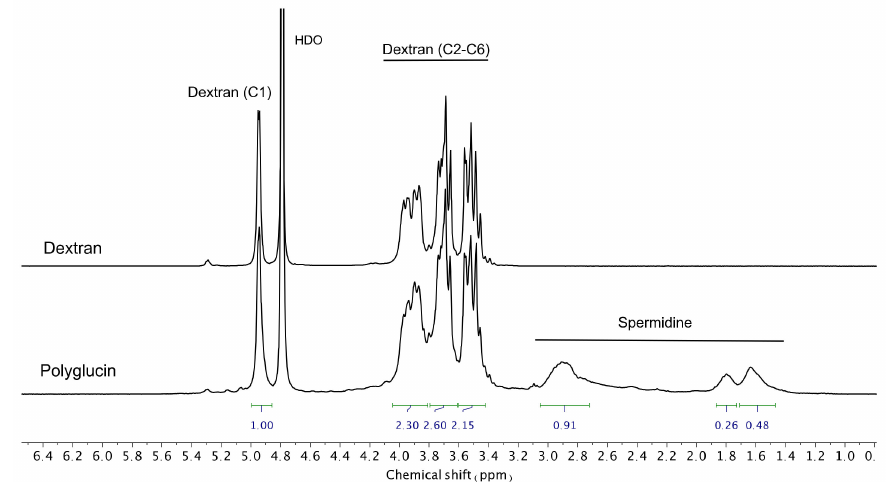
Figure 2. Hydrogen-1 nuclear magnetic resonance spectra (D 2 O) of Dextran 40,000 and